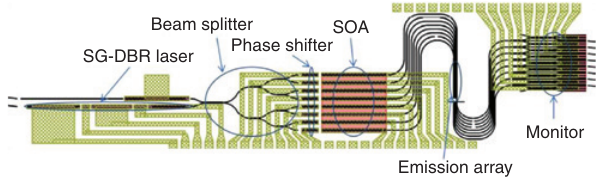
Figure 13: PIC design layout for a fully integrated indium phosphide based OPA, including tunable laser source, phase tuners, optical amplifiers (SOAs), grating emitters, and on-chip phase calibration